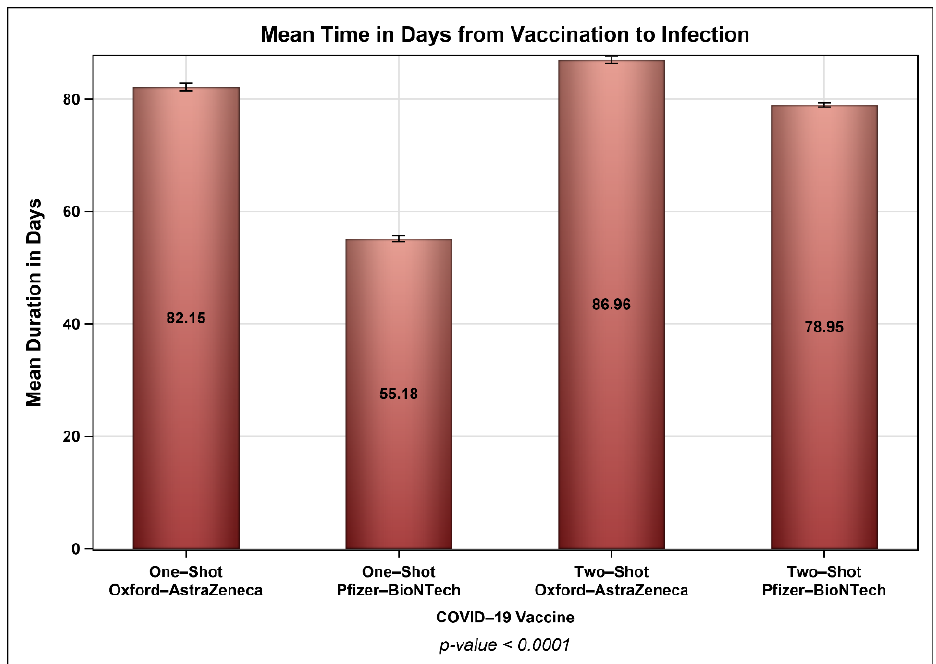
Figure 7. Time to infection based on the vaccine (Pfizer–BioNTech vs. Oxford–AstraZeneca) and number of injections. p -value is for one-way ANOVA.